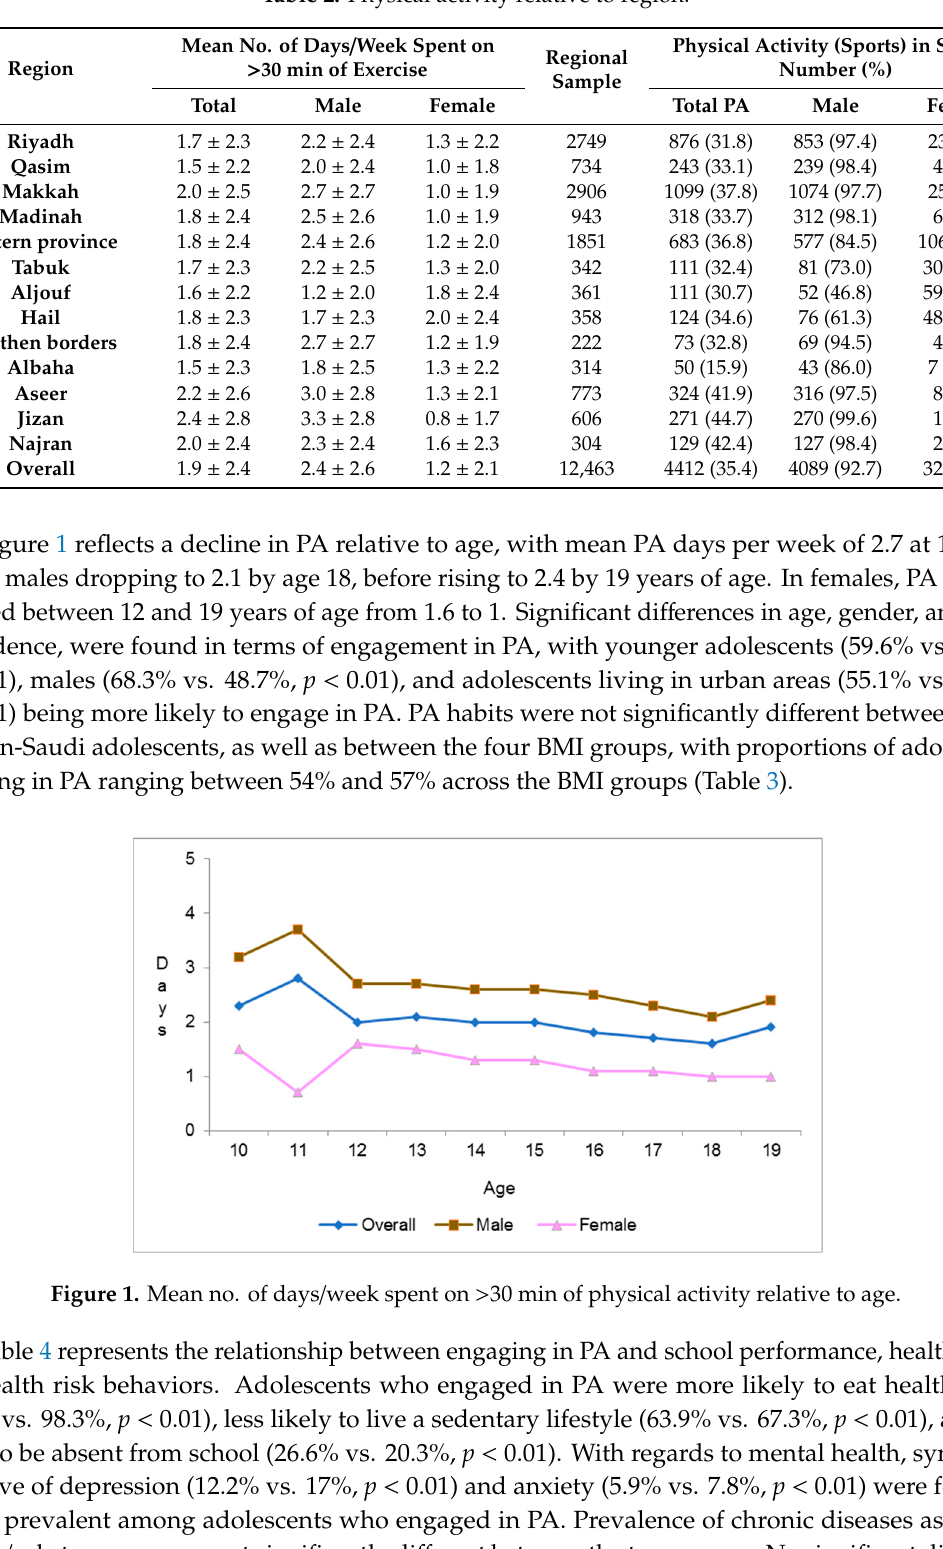
Table 2. Physical activity relative to region.